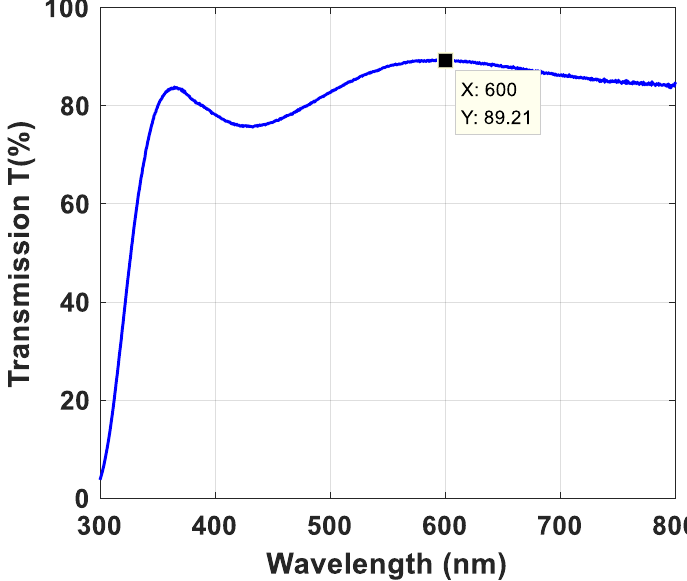
Figure 4. The measured transmission of the ITO film-based glass.